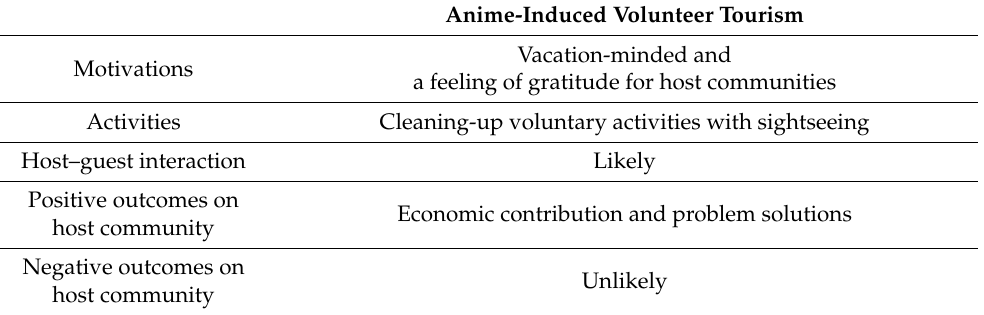
Table 3. Findings of the case